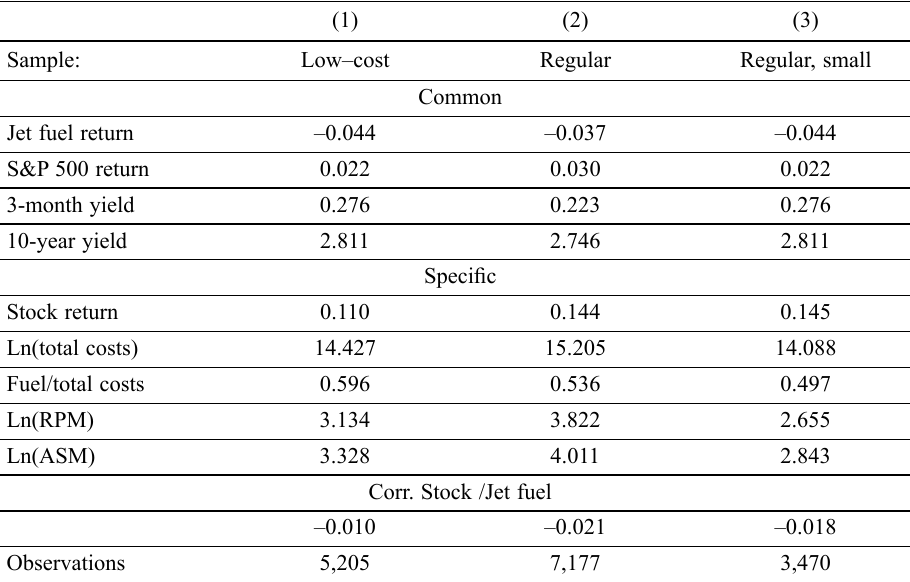
Table 3. Summary